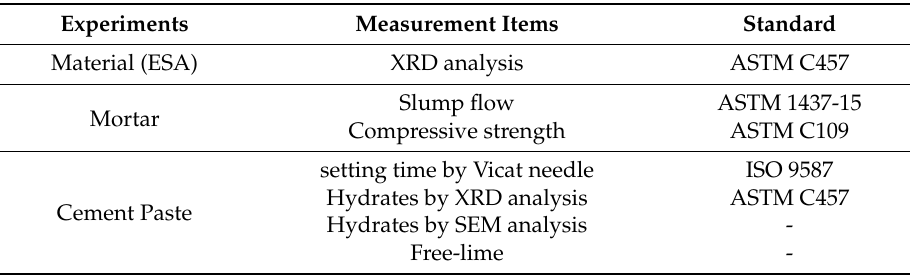
Table 7. Items measured for each